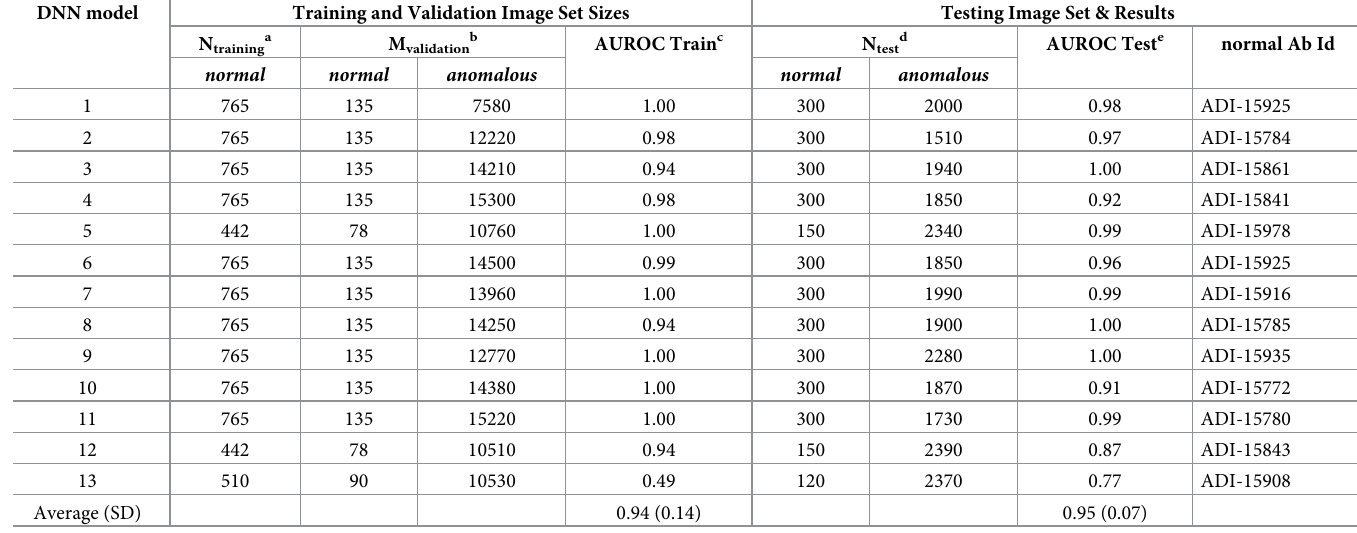
Table 11. Statistical summary of 13 DNN models trained to distinguish Abs from a specific family lineage from a large Ab set using the Robust Convolutional Auto- encoder (RCAE) one-class classification method. DNN model Training and Validation Image Set